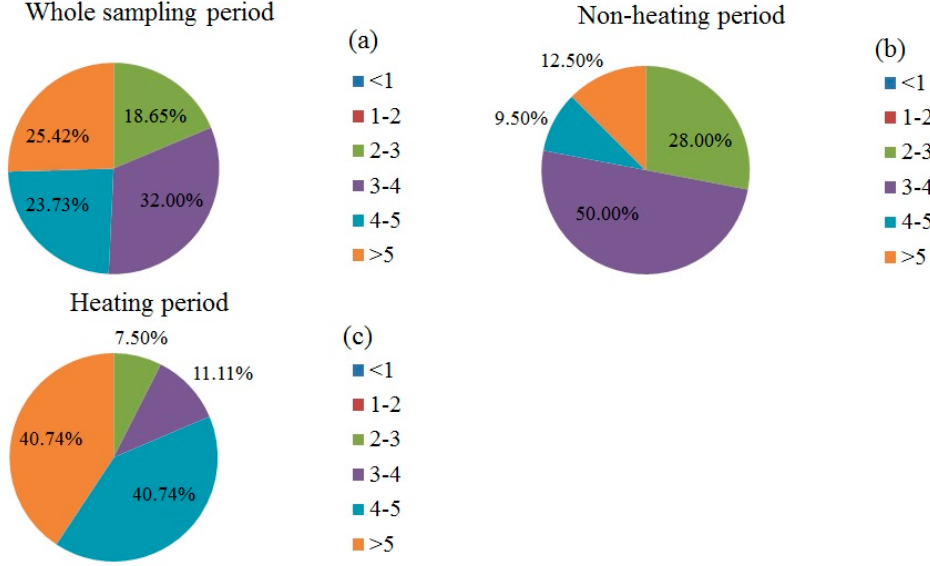
Figure 3. The distribution frequency of the pollution load index in different ranges.